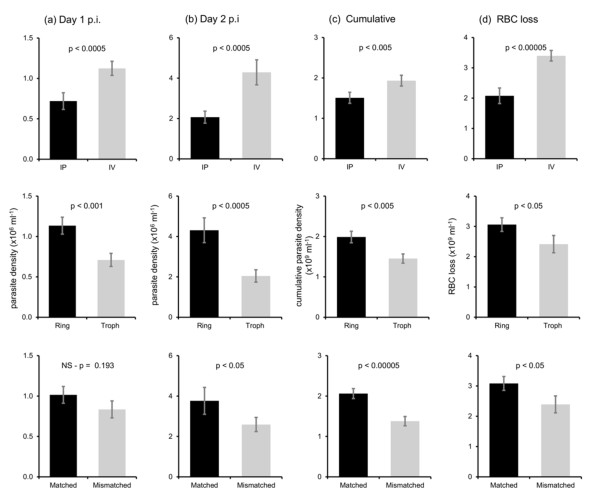
Parasites performed better when injected via intravenous, at ring-stage, and matched to host rhythms, resulting in greater virulence. Total parasite densities of infections (a) on day 1 post-infection, (b) on day 2 post infection, and (c) summed from day 1 to day 7 pi (cumulative density); (d) overall loss of RBCs during the pre-peak phase. Bars show mean (±se) densities of parasites or RBC with (a) n = 39 infections per group (b-d) n = 40 per group. The top row compares the route of infection either by IP (intraperitoneal injection, black bars) or IV (intravenous injection, grey bars). The middle row compares the parasite stage used to initiate the infections, with rings (black bars) or trophozoites (grey bars). The bottom row compares parasites on the same (matched, black bars) or perturbed (mismatched, grey bars) schedule as the host.